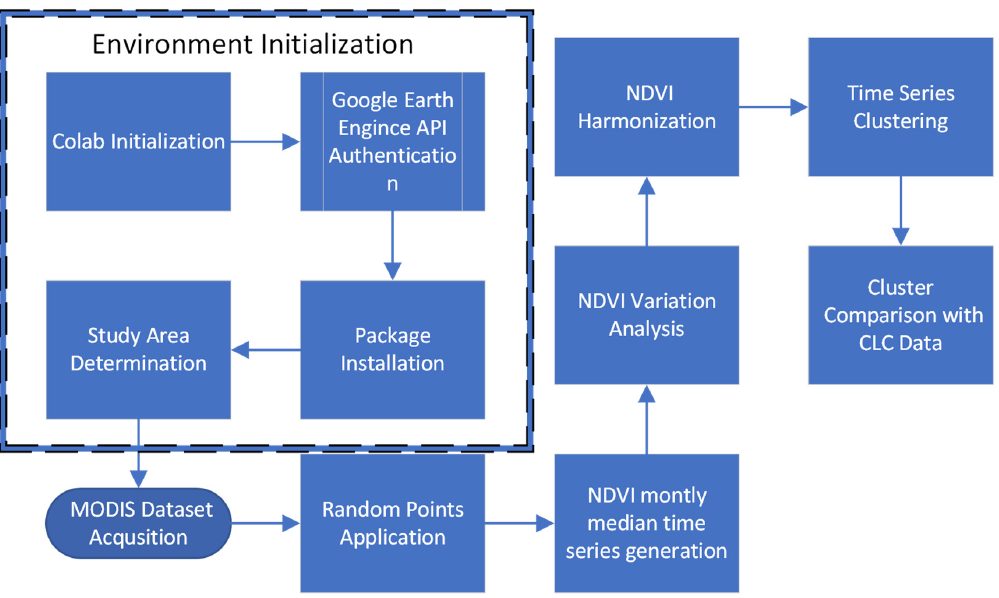
Figure 2. Overall workflow, environment initialization (dashed box) and methodology.